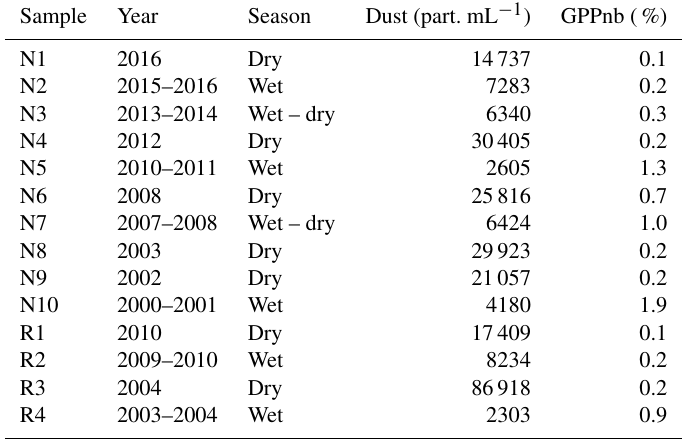
Table 1. Characterization of the Nevado Illimani samples analyzed for elemental (N1 to N10) and mineralogical (R1 to R4) composition.